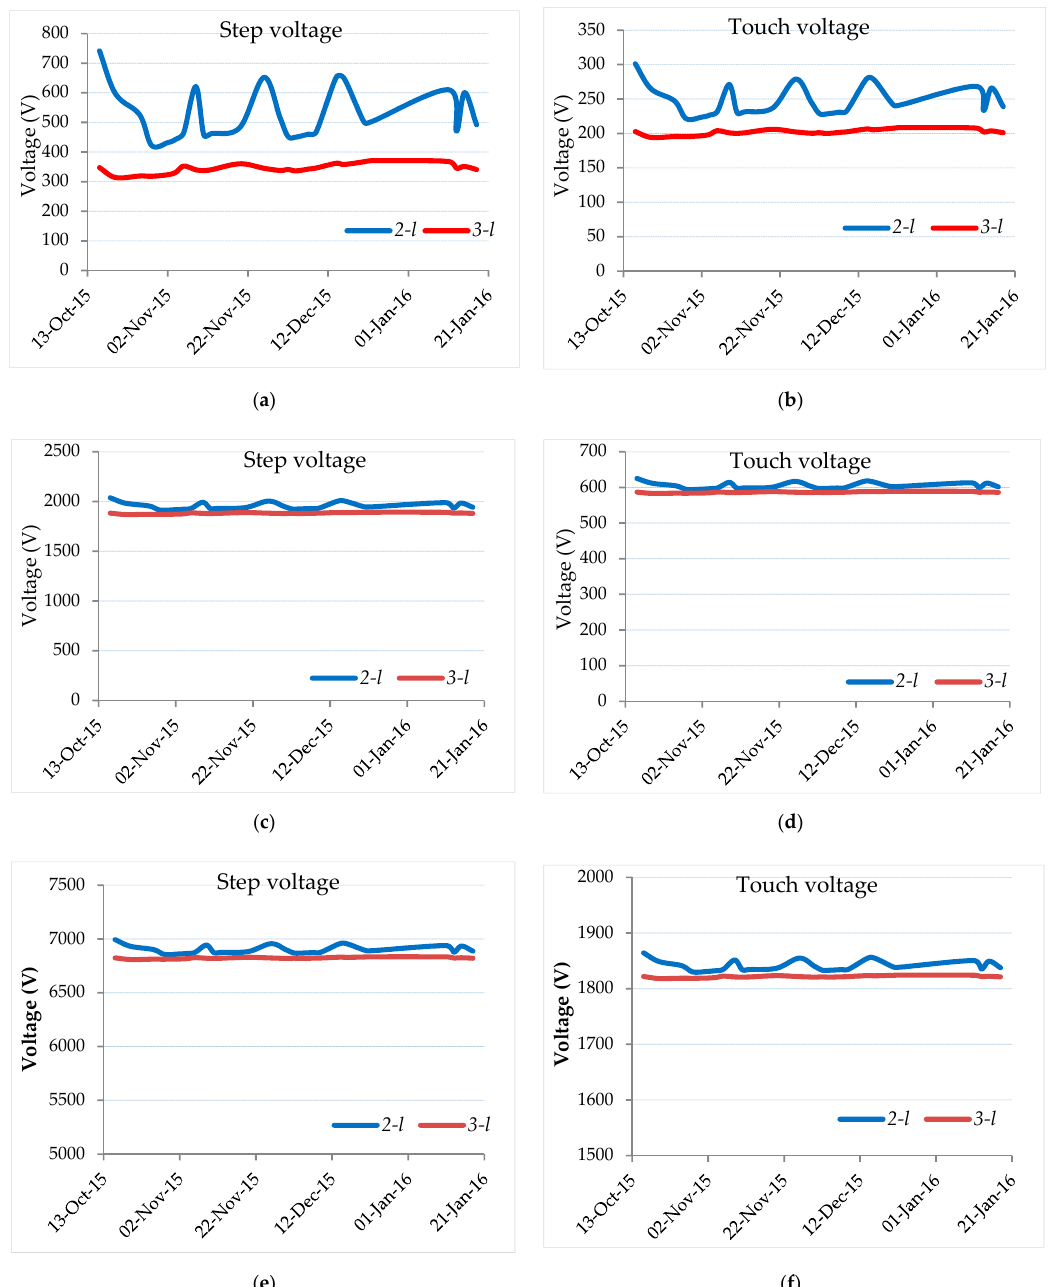
Figure 5. Variation of the maximum permissible limits for step and touch voltage as a function of time (blue line: two-layer soil model, red line: three-layer soil model): ( a , b ) Step and touch voltage with no surface layer, ( c , d ) step and touch voltage for surface layer of 2500 Ω∙ m (gravel), ( e , f ) step and touch voltage for surface layer of 10,000 Ω∙ m (asphalt) with a surface layer thickness of 10 cm.